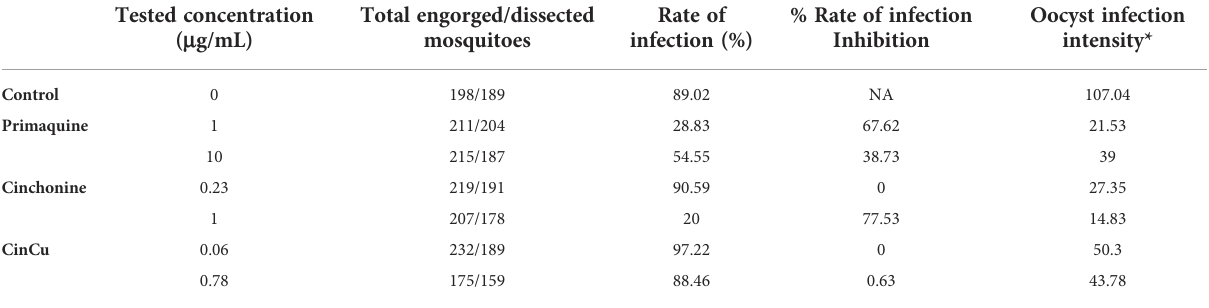
TABLE 4 Effect of blood treatment with cinchonine, primaquine, and CinCu on P. vivax infection rate, oocyst intensity and oocyst inhibition in A. aquasalis . Tested concentration Total engorged/dissected Rate of % Rate of infection ( m g/mL) mosquitoes infection (%)